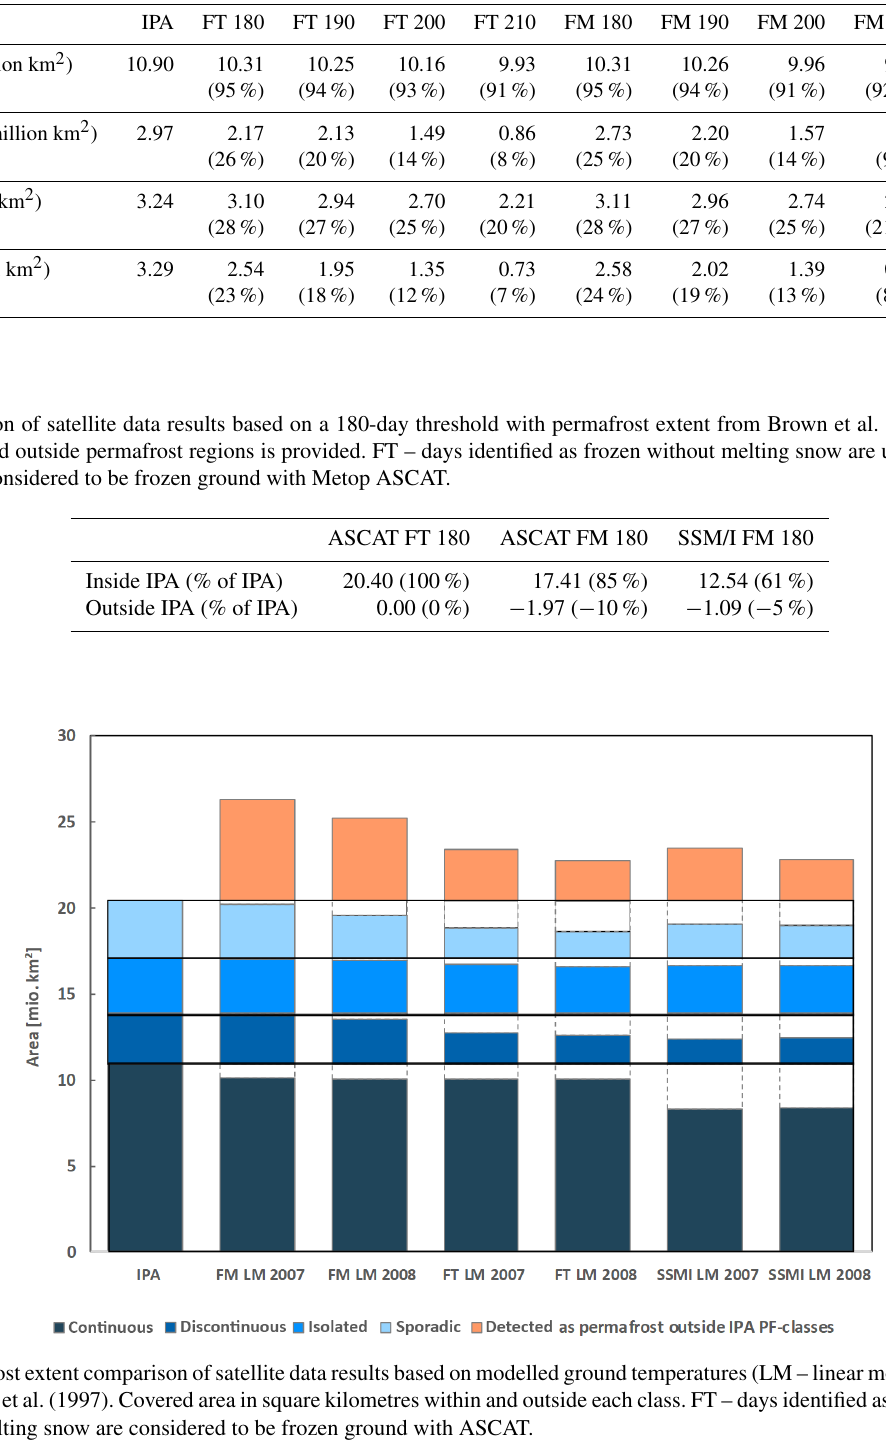
Table 2. Permafrost extent comparison of satellite data results from Metop ASCAT based on modified thresholds (180, 190, 200 and 210 days) with permafrost extent classes from Brown et al. (1997). Covered area is provided in square kilometres within each class. FT – days identified as frozen without melting snow are used; FM – days with melting snow are considered to be frozen ground with Metop ASCAT. SSM/I classification results based on 180 days are included for comparison.